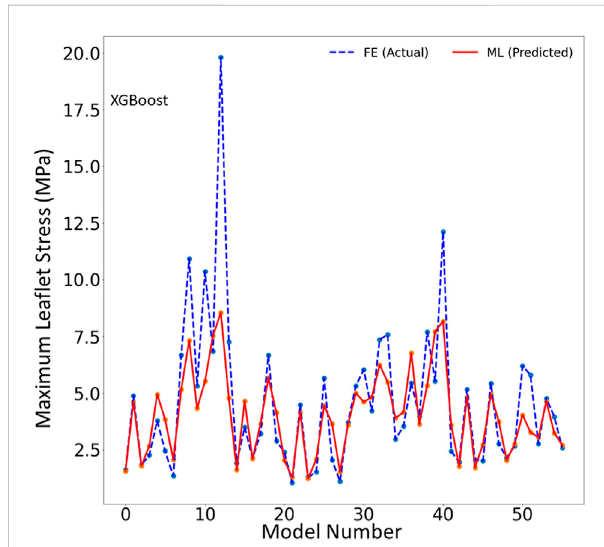
FIGURE 3 The maximum lea fl et von Mises stress for the test set obtained from FE (ground truth) and XGboost (predicted). Python (3.7, https:// www.python.org/) was used to create this fi gure.